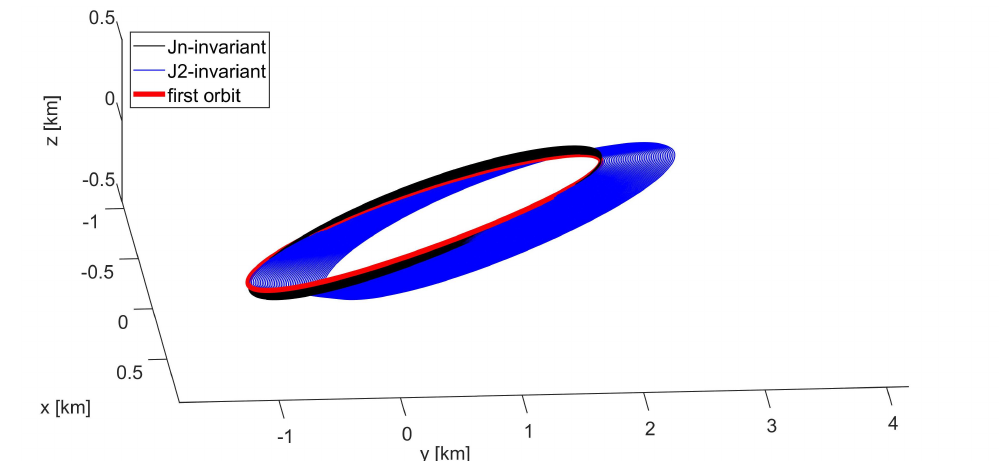
Figure 9. Mid-inclination eccentric LEO formation: trajectory in F r resulting from J n -invariant and J 2 -invariant initial conditions; the first orbit is plotted in red.